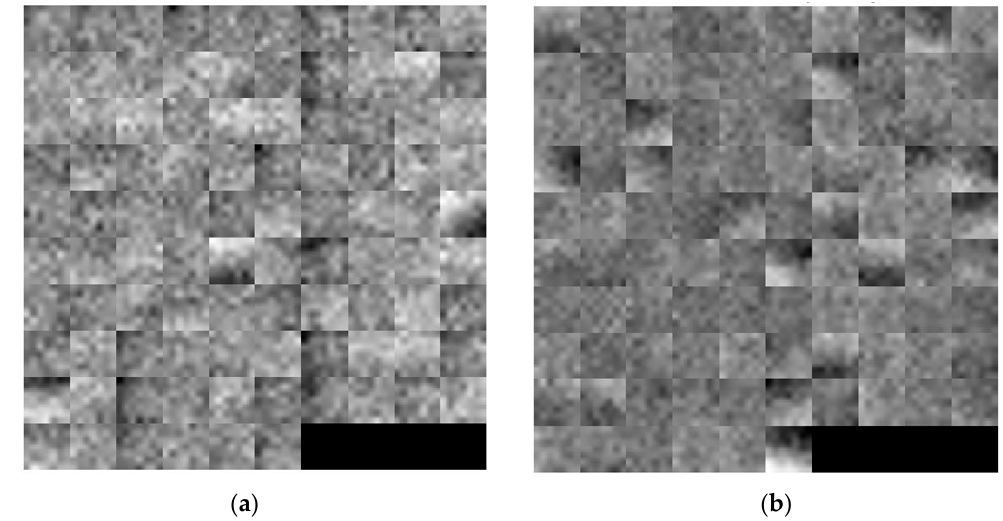
Figure 9. The 96 trained convolution filters in the size of 7 × 7 × 1 obtained in the first convolution layer using our CNN configuration in Figure 5 and our training database: ( a ) the filters obtained using visible light images, and ( b ) the filters obtained using thermal images.